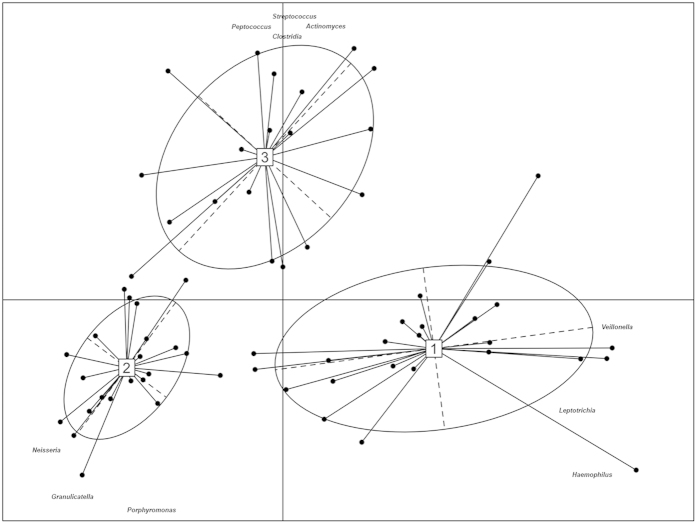
Operational taxonomic unit abundance drives the differentiation of salivary types.Between-class analysis visualizing the results from Principal Component Analysis and clustering based on the Jensen-Shannon distance of the saliva samples analyzed in this study. The center of gravity for each cluster is marked by a rectangle indicating the salivary type, and the ellipse covers 67% of the samples belonging to the cluster. Only operational taxonomic units with loadings >=0.7 in at least one cluster are shown in the figure.